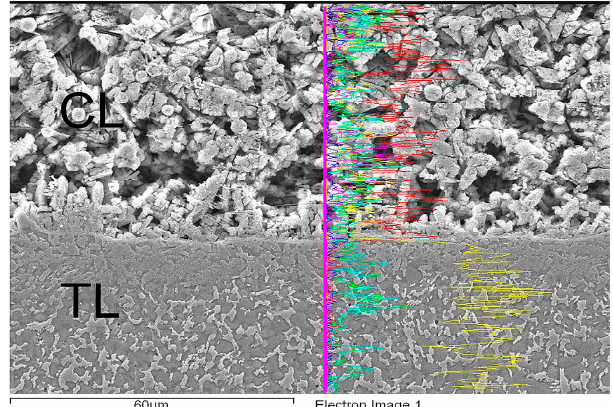
Figure 9. Cont. Figure 9.